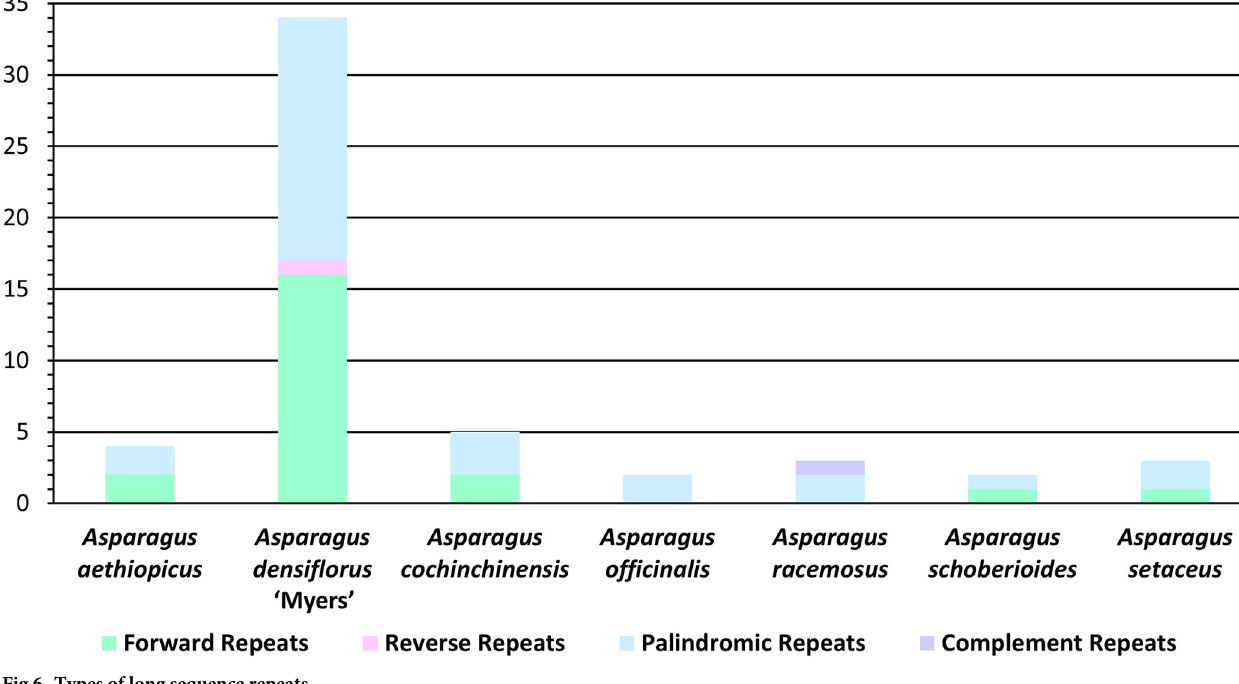
Fig 6. Types of long sequence repeats.